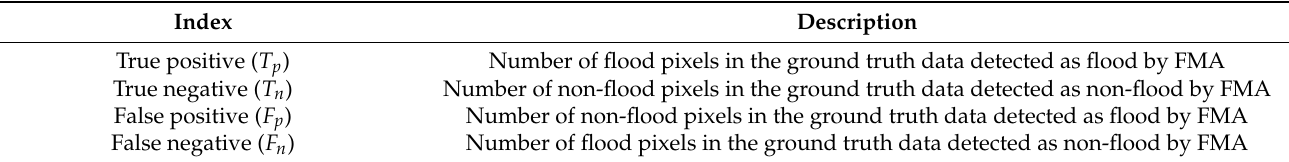
Table 3. Performance indices for